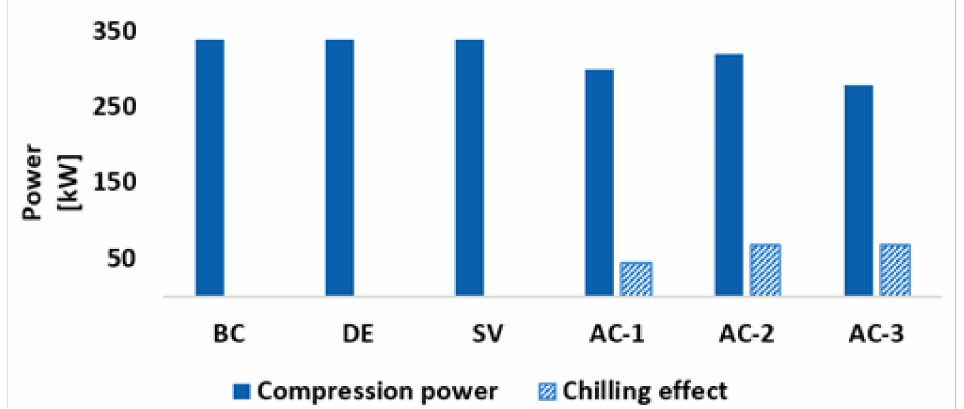
Figure 9. Compression power and recovered chilling effect for the various cases.